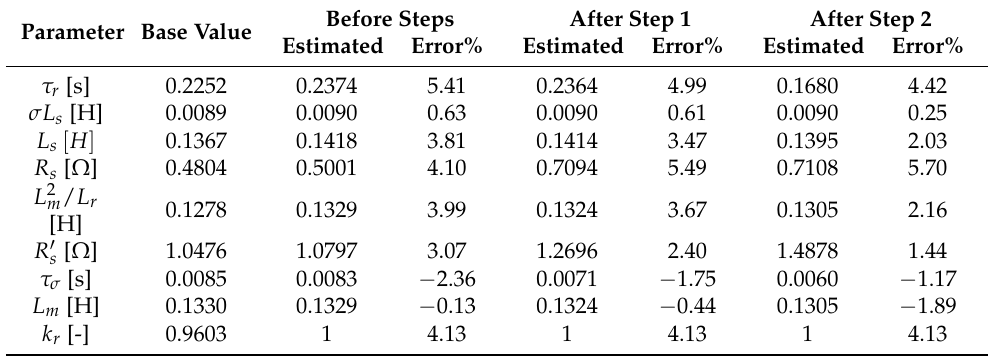
Table 2. N-MRAS_e results in front of Step 1 and Step 2 changes.